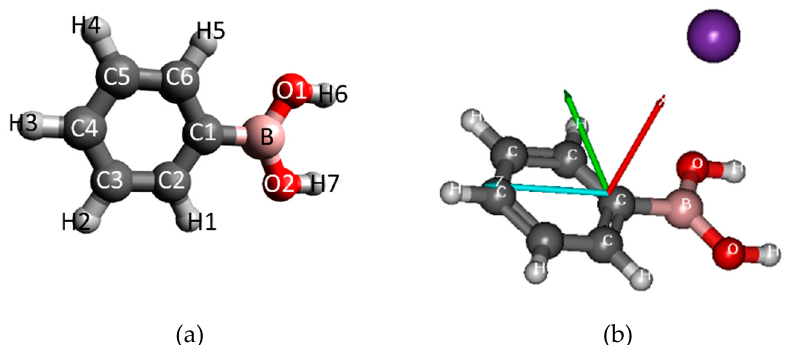
Figure 7. ( a ) Molecular structure of PBA, including atom numbering ( b ) and orientation of the potassium (K) + PBA collisional system.